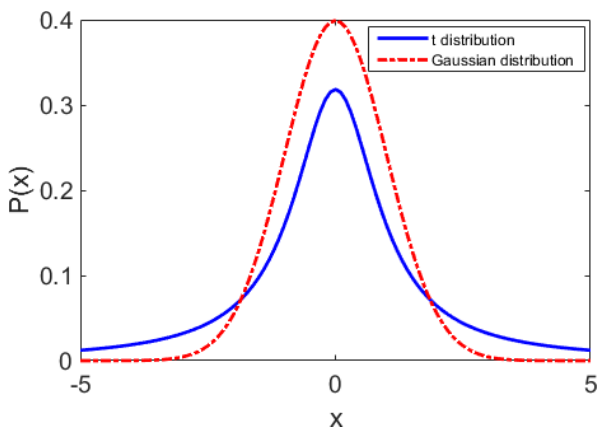
Figure 2. Red curve: the Gaussian distribution for data points, ex- tending from − 5 σ to 5 σ . The mean of the distribution is at 0. Blue curve: the Student’s t distribution over the same range. The distri- bution is heavy-tailed, compared to the Gaussian